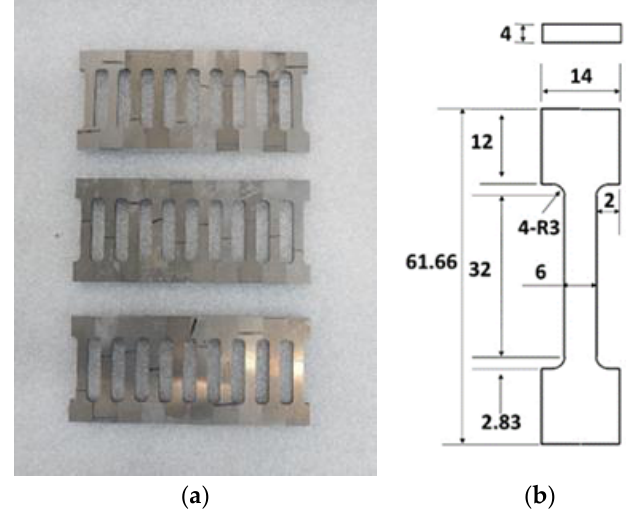
Figure 1. ( a ) machined specimens and ( b ) dimensions (mm). Table 1. Physical and material properties of 5005 aluminum alloy. Table 1. Physical and material properties of 5005 aluminum alloy. Properties Melting